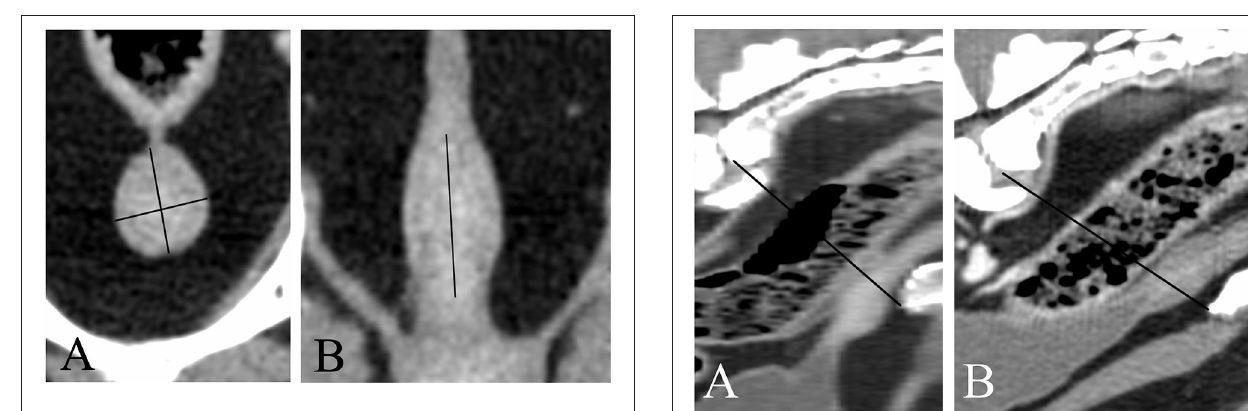
FIGURE 1 | Transverse (A) and dorsal (B) CT-reconstruction showing the prostate of a neutered dog. Length, height, and width are measured (black lines).